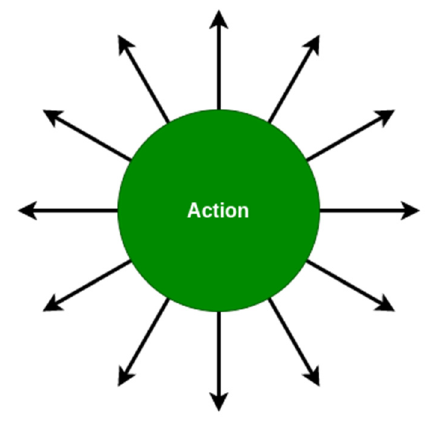
Figure 4. The quadrotor action definition in global path